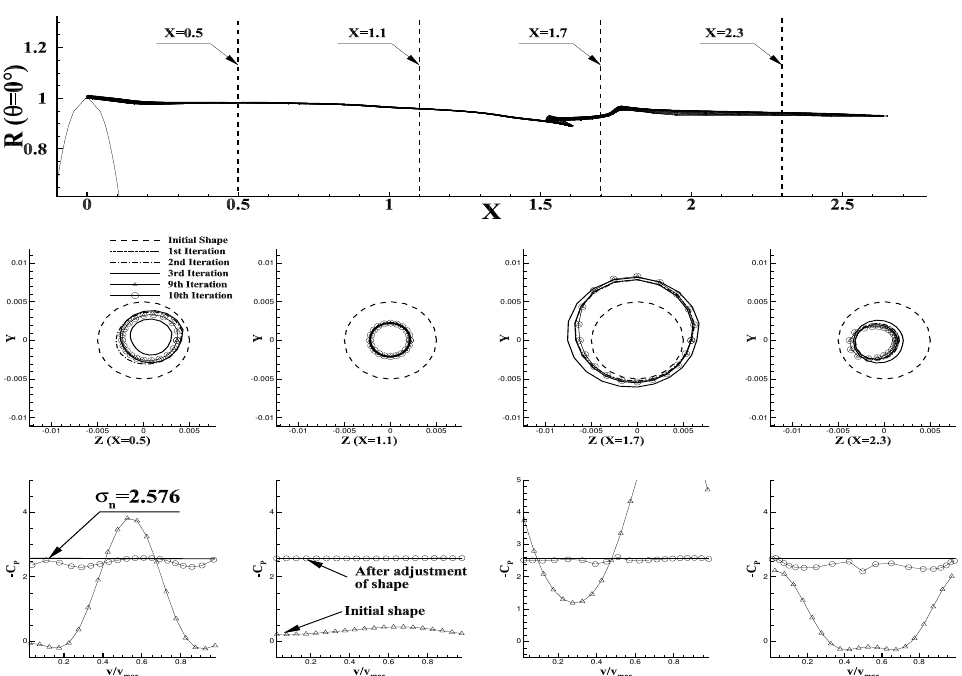
Figure 20. Projected view of the developed tip vortex cavitation from the BEM at blade angle θ = 0 ◦ on X − R plane ( up ). Convergence history of the cavitation sections at the denoted downstream locations ( middle ). Pressure distributions on the tip cavity surface at the same locations from the initial and the converged shape ( bottom ).